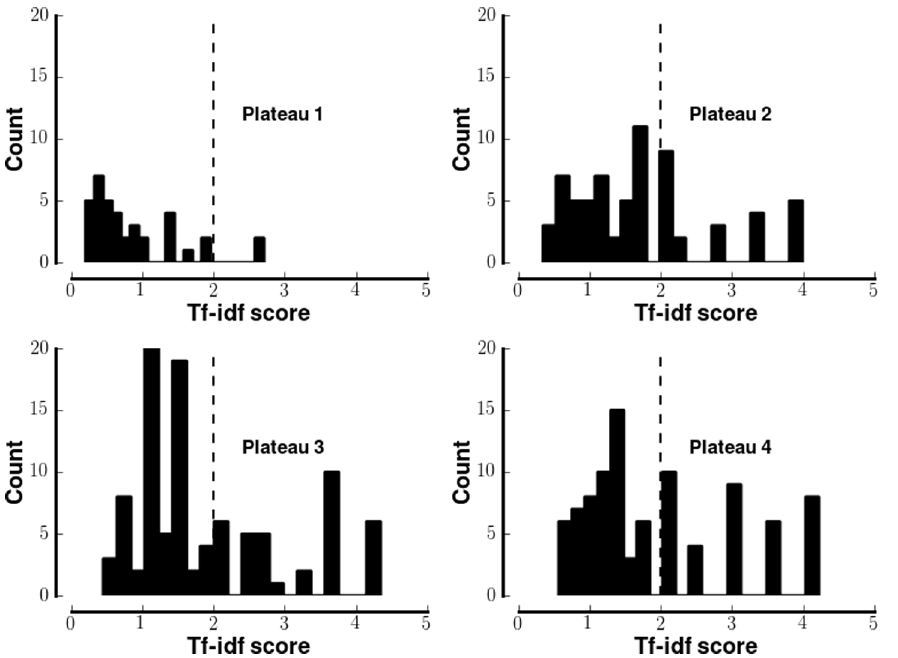
Figure 9. Distribution of tf-idf scores for YouTube comments. Each panel shows the distribution of tf-idf scores for YouTube comments stratified by the plateaus defined in [25]. The dotted line shows the threshold beyond which the tf-idf score indicates that the word indicates a specific plateau.